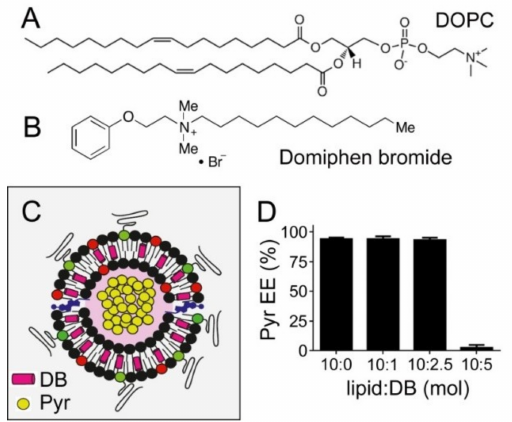
Figure 5. Co-encapsulation in liposomes of pyronaridine and DB. ( A , B ) Chemical structures of DOPC and DB. ( C ) Scheme of pyronaridine and DB co-encapsulation. ( D ) Encapsulation e ffi ciency (EE) of pyronaridine in liposomes (5 mM lipid, ca. 10:1 lipid:pyronaridine initial ratio) at di ff erent lipid:DB